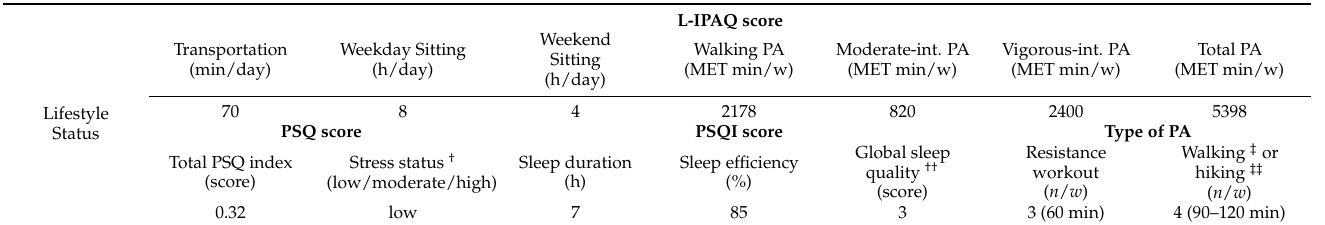
Table 5. Lifestyle